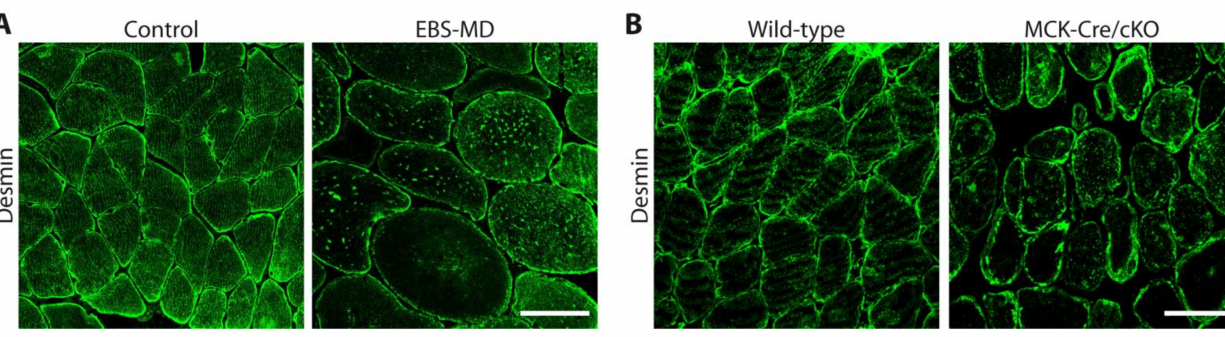
Figure 4. Immunofluorescence staining for desmin (in green) of cross sections from frozen skeletal muscle samples from a healthy control in comparison to an EBS-MD patient ( A ), and from a wild-type mouse in comparison to the conditional muscle-specific MCK-Cre/cKO mouse ( B ), which reveals the disruption of the desmin IF network and the formation of desmin-positive subsarcolemmal and cytoplasmic protein aggregates in plectin-deficient muscles. Scale bars: 100 µ M ( A ), and 50 µ M ( B ). (Images in ( A ), courtesy of R.